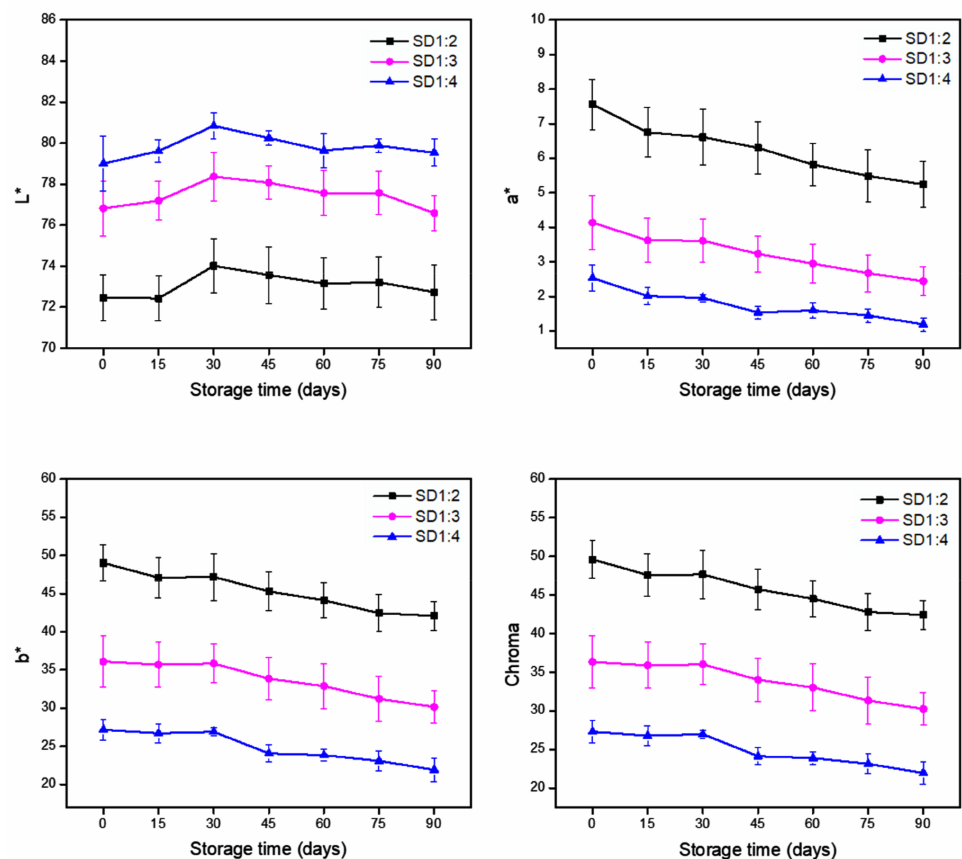
Figure 2. L*, a*, b*, and Chroma parameters obtained for each formulation produced by spray drying in instrumental color analysis during storage at 25 ◦ C. The formulations denote the proportion of the core:carrier